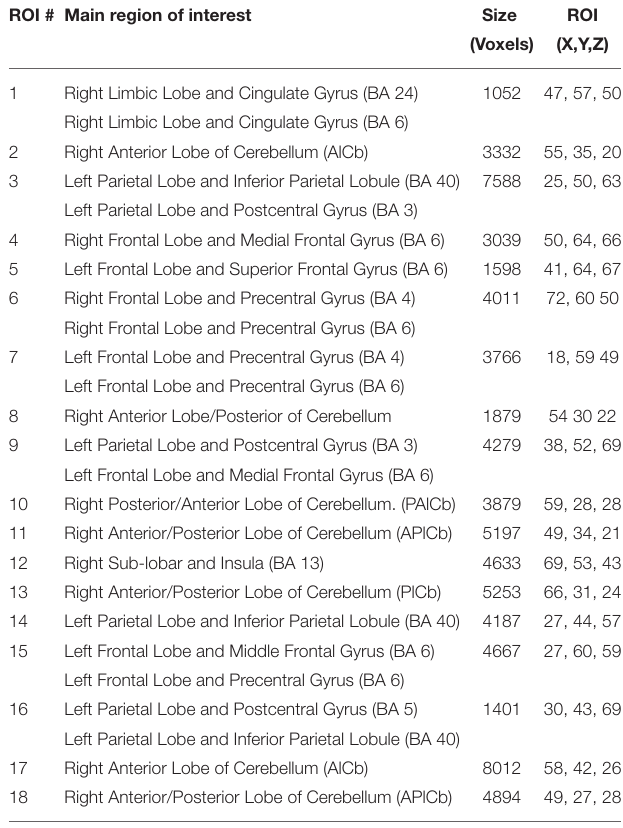
Table listing all the task ROI derived from the group ICA of controls. The number of voxels correspond to the size of each ROI in 2mm standard MNI space. X, Y, Z coordinates refer to standard MNI space. Percentages listed are for each gray matter region that encompassed more than 5% of a given ROI. Names provided are based on the labels of the Talairach Atlas. BA, Brodmann’s